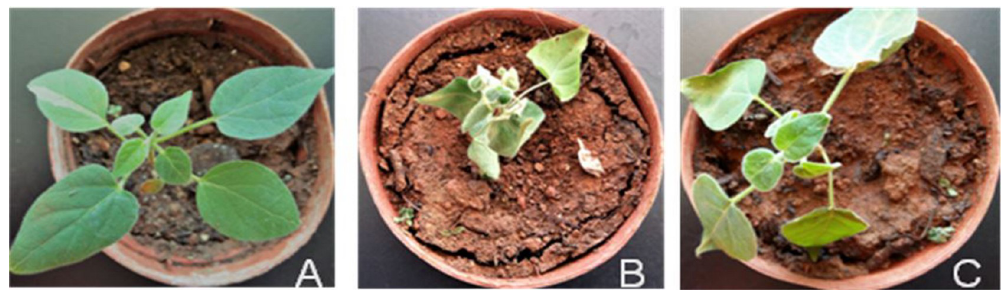
Fig 1. The phenotype of three groups of M . tenacissima